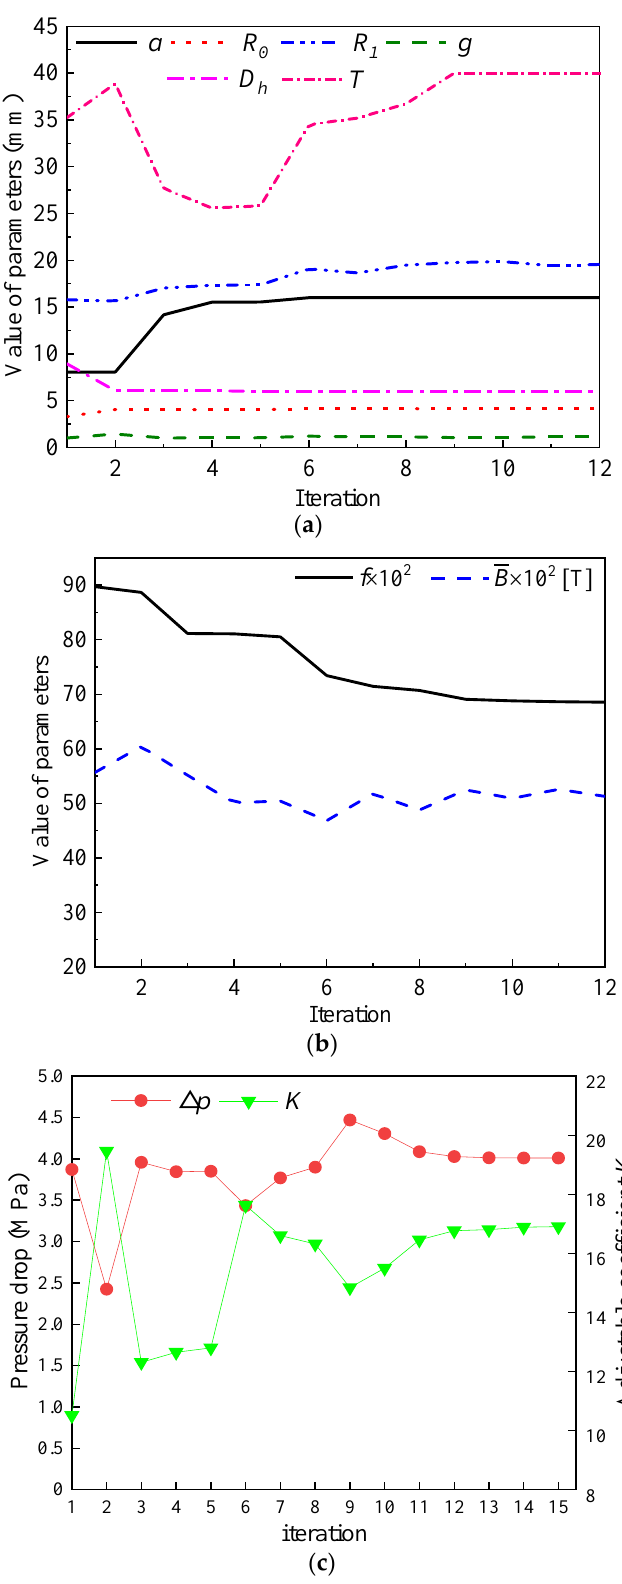
Figure 17. Optimization result of proposed radial MR valve: ( a ) Design variables, ( b ) objective function and state variables, and ( c ) pressure drop and adjustable coefficient. Table 1. Performance of the initial and optimal radial MR valve.